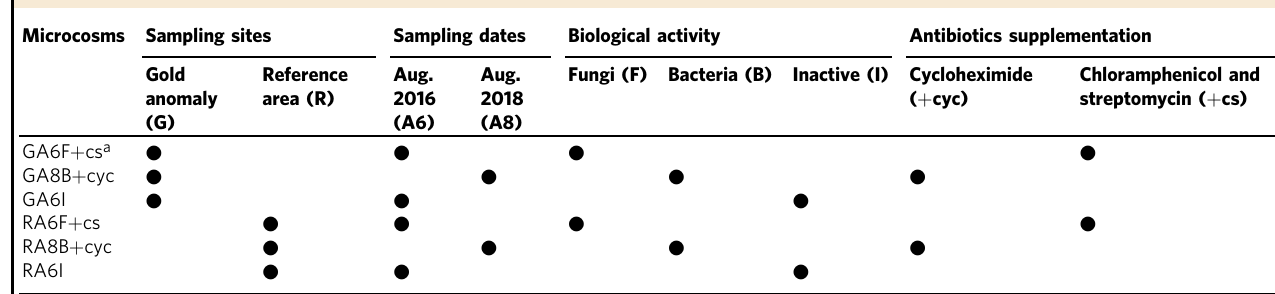
a A black dot means the condition was applied to construct the